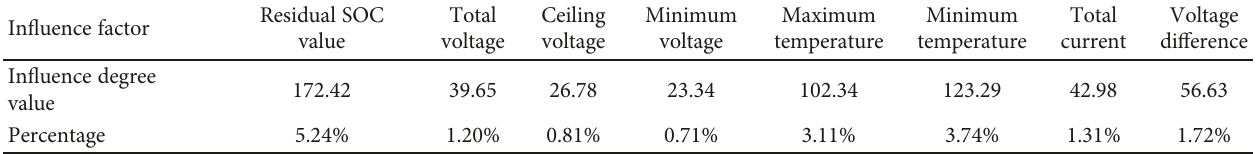
Table 1: The in fl uence degree of energy consumption in fl uence factors (battery).